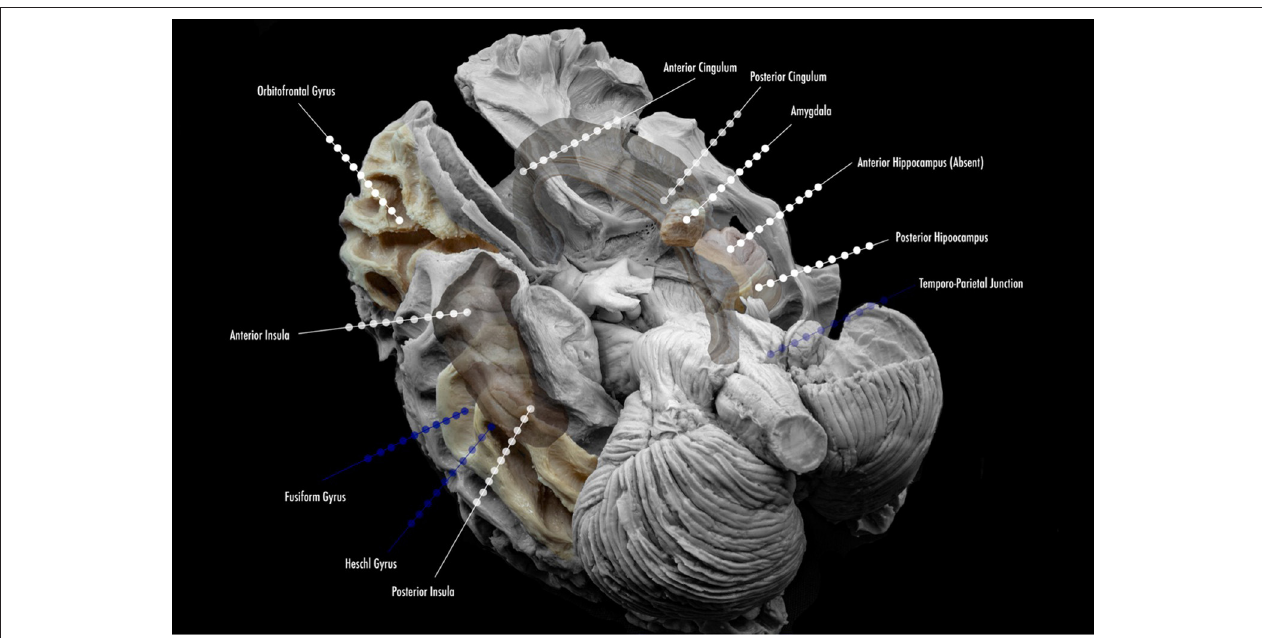
FIGURE 2 | Proposed scheme of electrode implantation maps for insertion. Lined white dots show usual trajectories and sites of insertion in the study of temporal lobe epilepsy. Lined blue dots show additional electrode locations for the study of temporal plus epilepsies, and common sites of propagation.